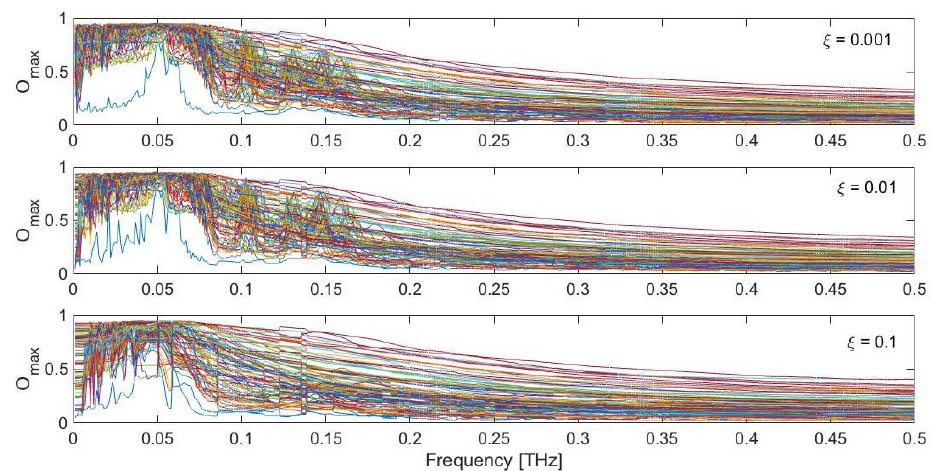
Figure 6. Maximum obtained overlap score for the LAO-binding protein response with respect to the observed conformational change, as a function of damping ( ξ = 0.001, 0.01, 0.1) and different random force patterns. Each colored curve represents one of the 100 different random force patterns.